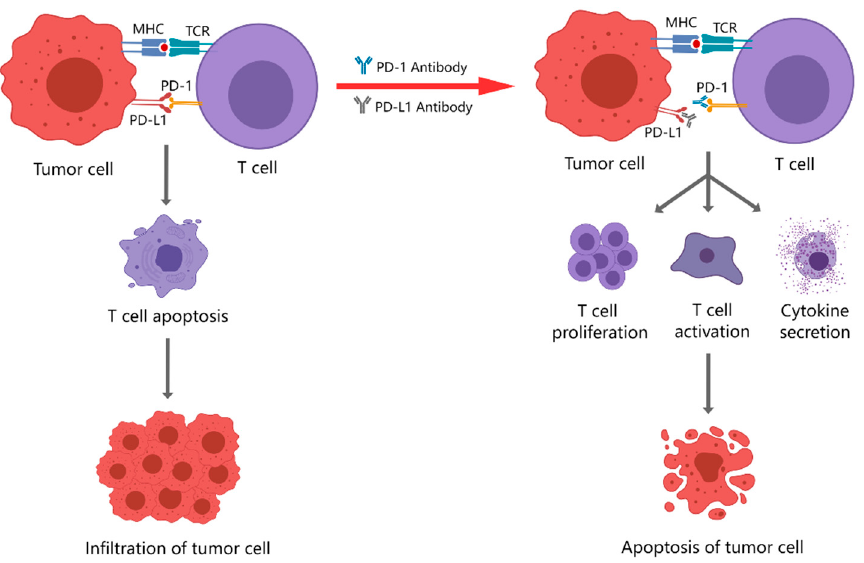
Figure 2. Effect of PD-1 and PD-L1 inhibitors. The combination of PD-1 and PD-L1 induces T-cell apoptosis, so the tumor cells will infiltrate; the use of PD-1 or PD-L1 inhibitors promotes T-cell proliferation, activation and secretion of cytokines, and enhances the tumor-killing effect of T